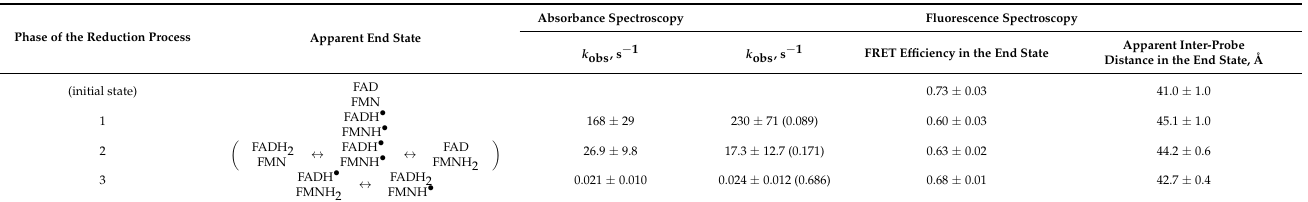
Table 1. Parameters of the SbCPR reduction as determined with absorbance and fluorescence stop- flow spectroscopy